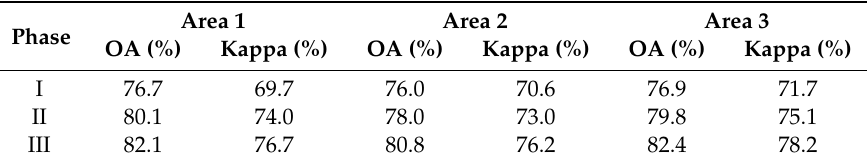
Table 2. Comparison of the overall accuracies and Kappa statistics for the three phases in three Vaihingen sites.